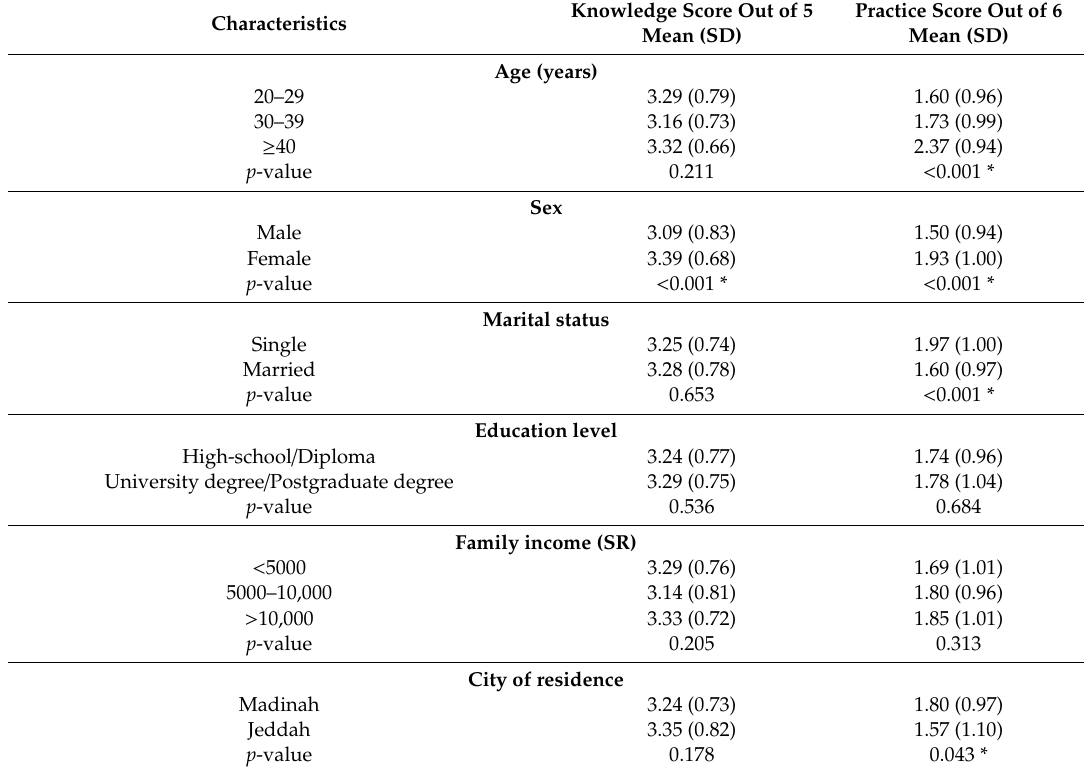
Table 3. Association between salt-related knowledge and practices and sociodemographic and physical characteristics ( n =